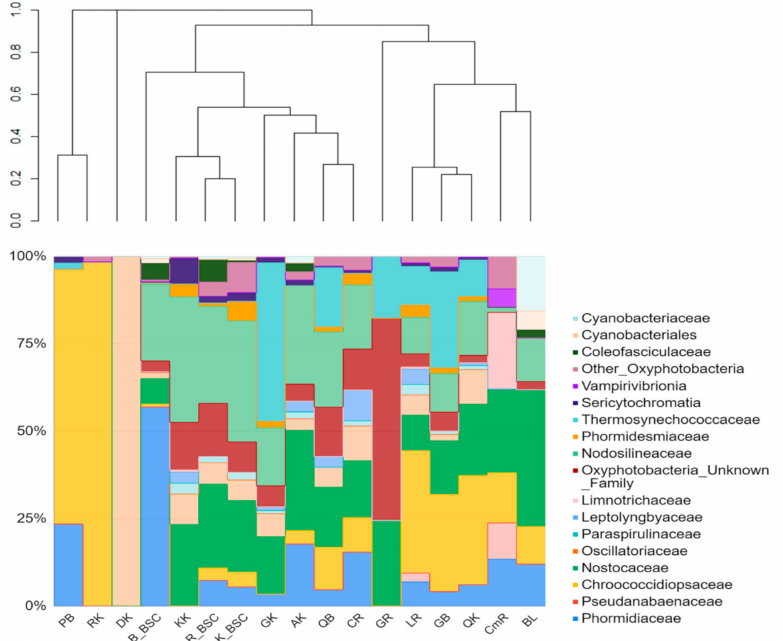
Figure 5. The relative abundance of cyanobacterial taxa occurring in the rocks in Eastern Pamir. The sample groups’ IDs include the first letter of the rock type. The second letter was given